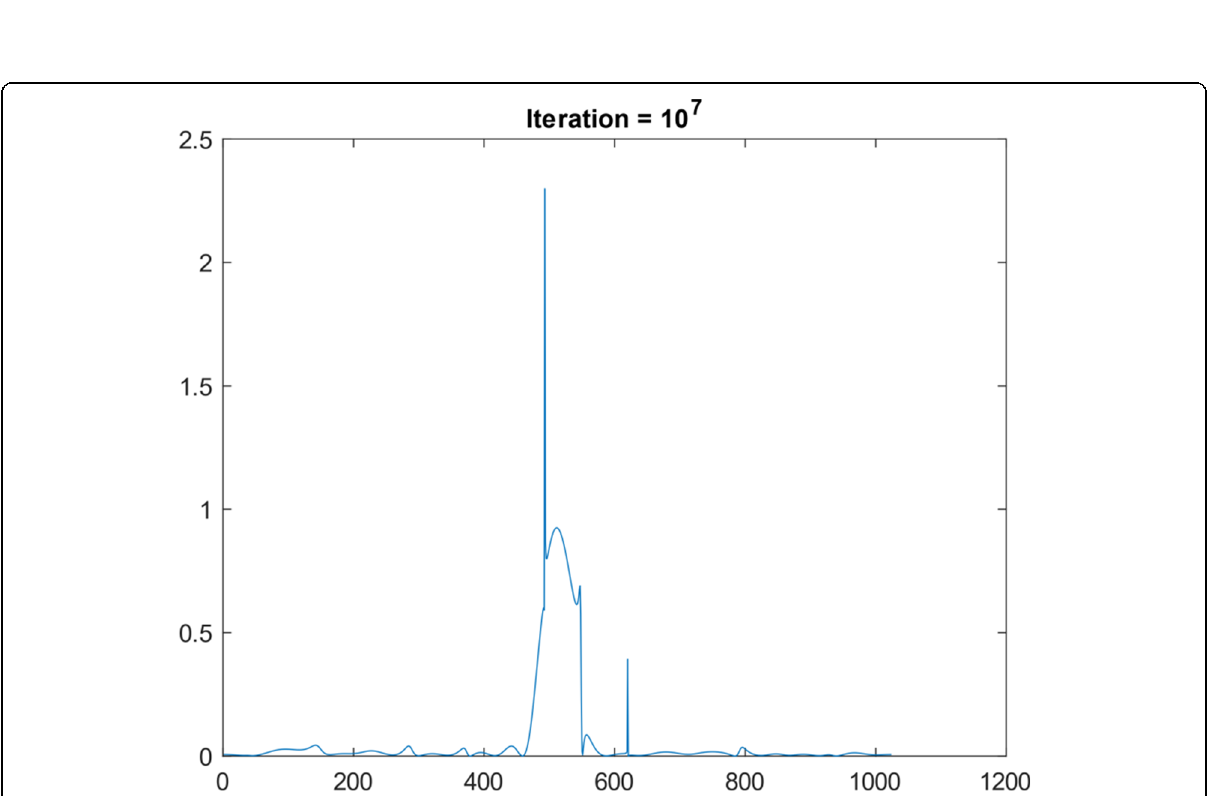
Fig. 14 Restored the Gaussian function after 10 7 iteration of suggested algorithm using noisy